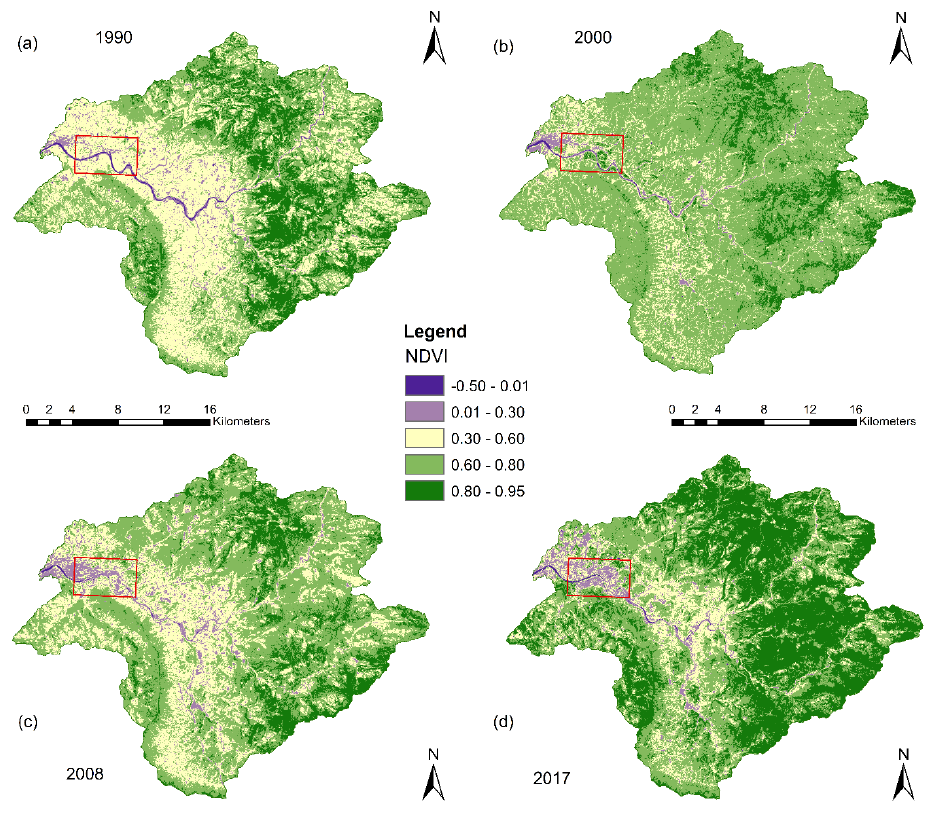
Figure 8. Spatial variations of the NDVI of the Guangyuan watershed for 1990 ( a ), 2000 ( b ), 2008 ( c ) and 2016 ( d and 2016 ( d ).